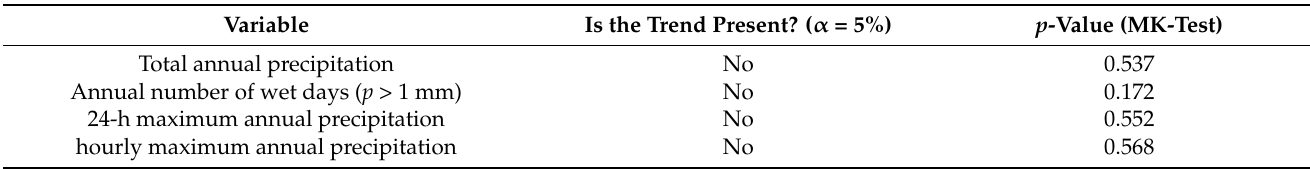
Figure 10a–d: all of them below the significant threshold considering α = 5%. Table 2. Summary of MK test results on precipitation series.